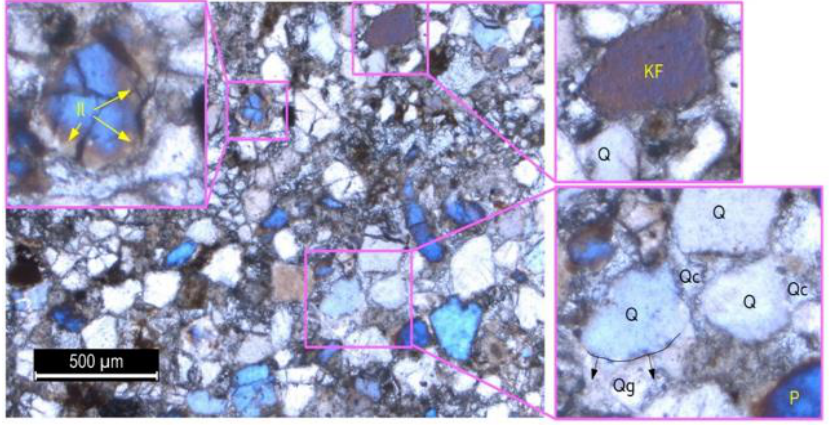
Figure 16. Textural and compositional features of L3-01. (Q) Quartz, (P) pore space, (KF) kaolinite filling, (Qg) quartz overgrowth, (Qc) quartz cement, and (Il) illite lining.